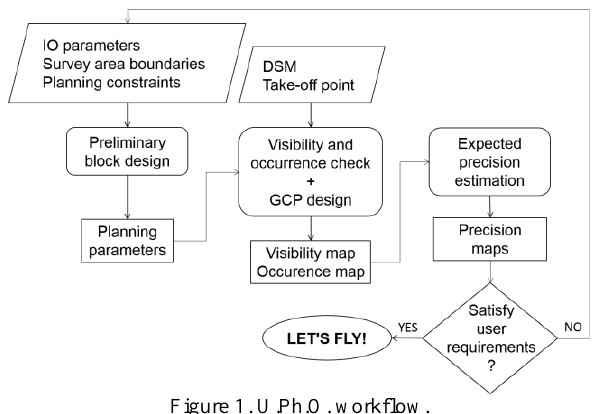
Figure 1. U.Ph.O.